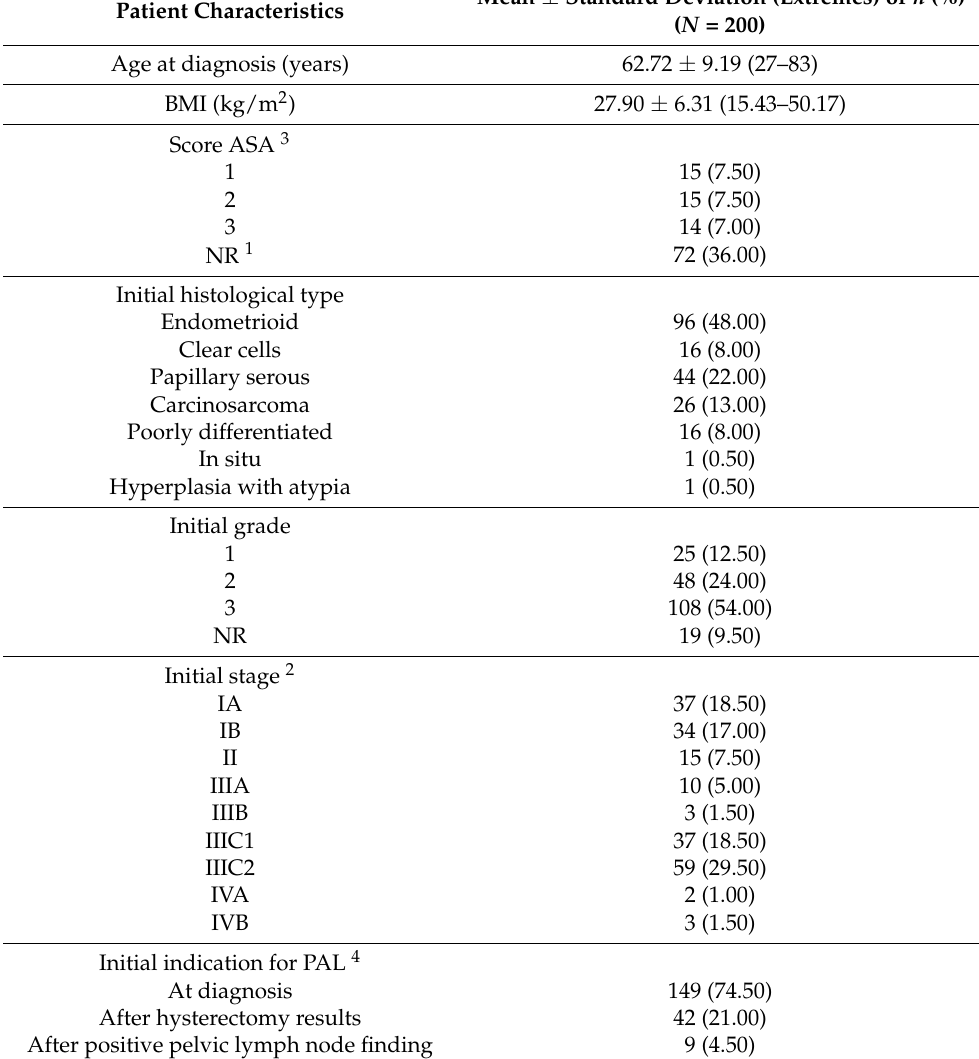
Table 1. Patient